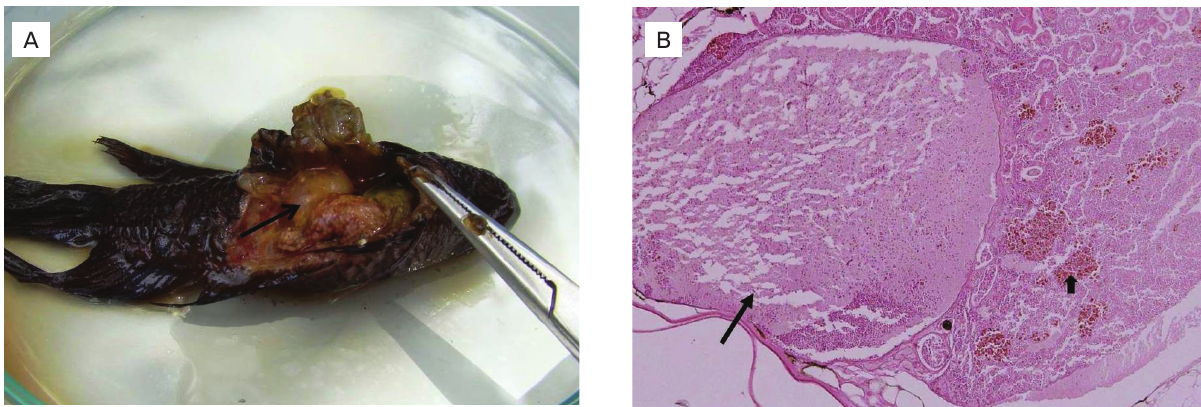
Figura 1. Abscesso subcutâneo em peixe Betta splendens , infiltrando na cavidade celomática. (A) Nota-se presença de tecido necrosado, edemaciado e exsudato fibrinoso difuso na cavidade celomática (seta). (B) Nota-se cavidade preenchida por heterófilos e detritos celulares em meio à deposição de fibrina, revestido por cápsula de tecido conjuntivo (seta), além de hemorragias no tecido muscular (cabeça de seta). HE, obj. 10 x, barra = 240 μ m.